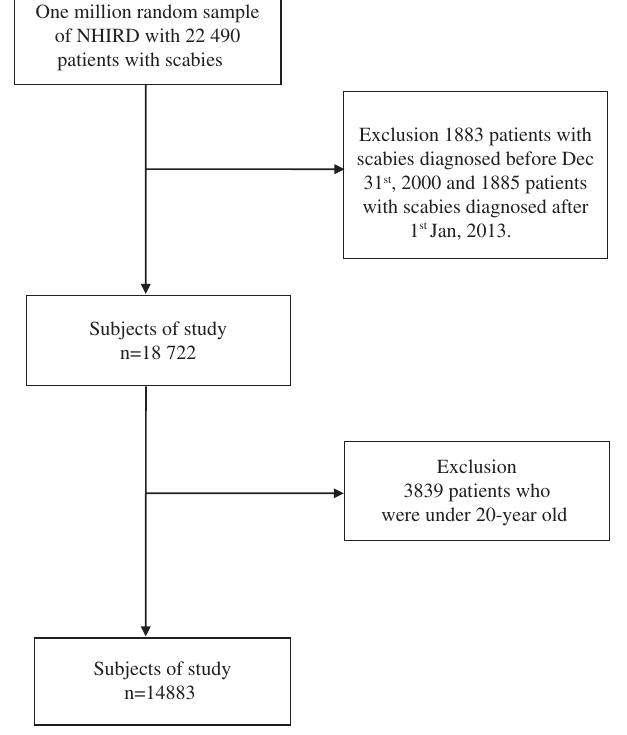
Table 1. Demographic characteristics of patients with scabies in Taiwan, from 2000 to 2013.